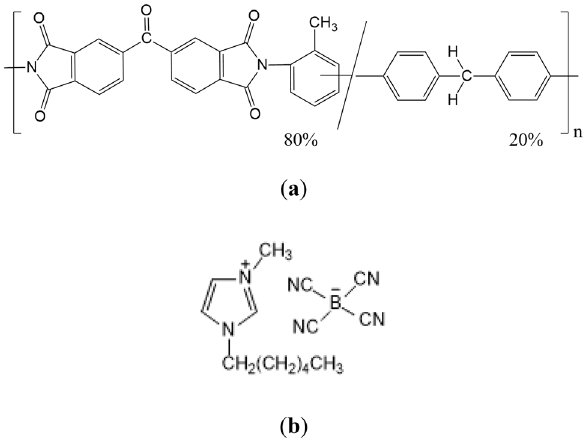
Figure 1. Structural formulas of ( a ) P84 copolyimide and ( b ) 1-hexyl-3-methylimidazolium tetracyanoborate